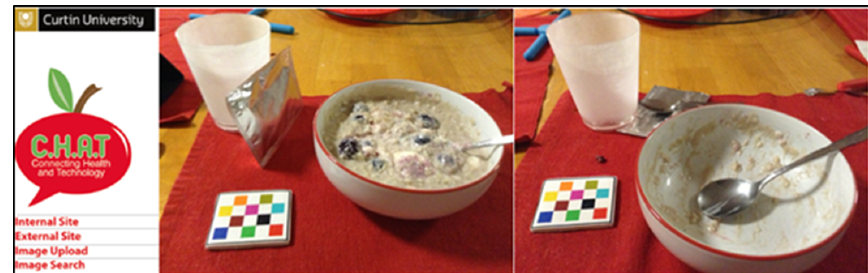
Figure 2. Before and after images of an eating occasion with foil sachet containing PGXG and fiducial marker captured with the mobile food record App on an iPod.